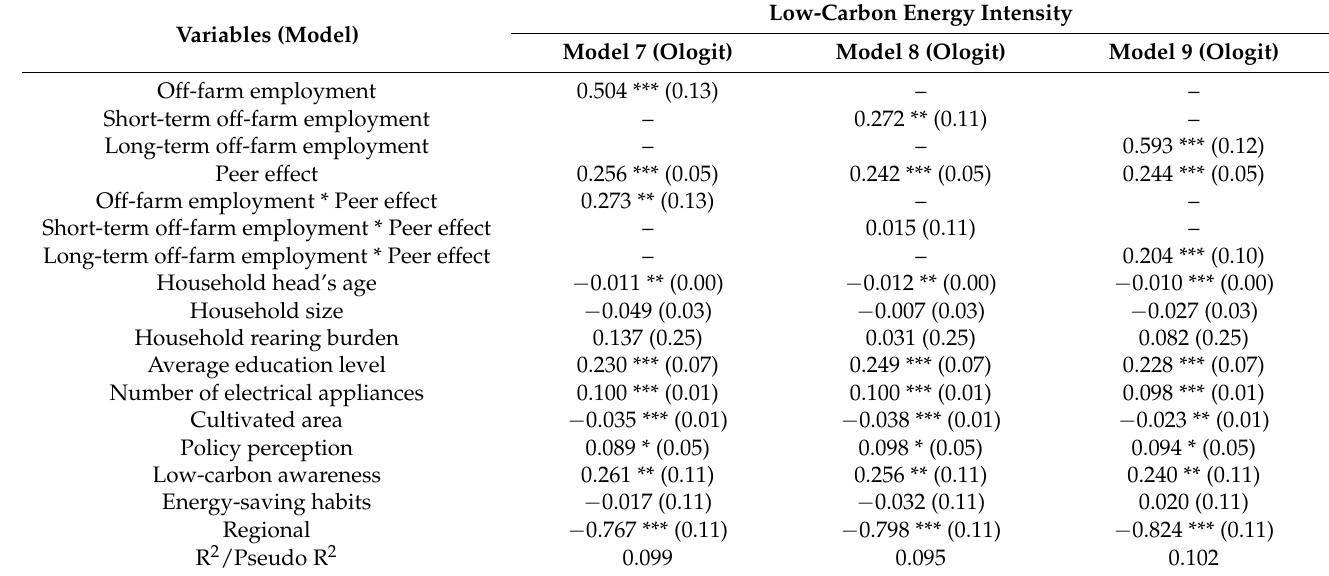
Table 5. Adjustment test of peer effect (N =